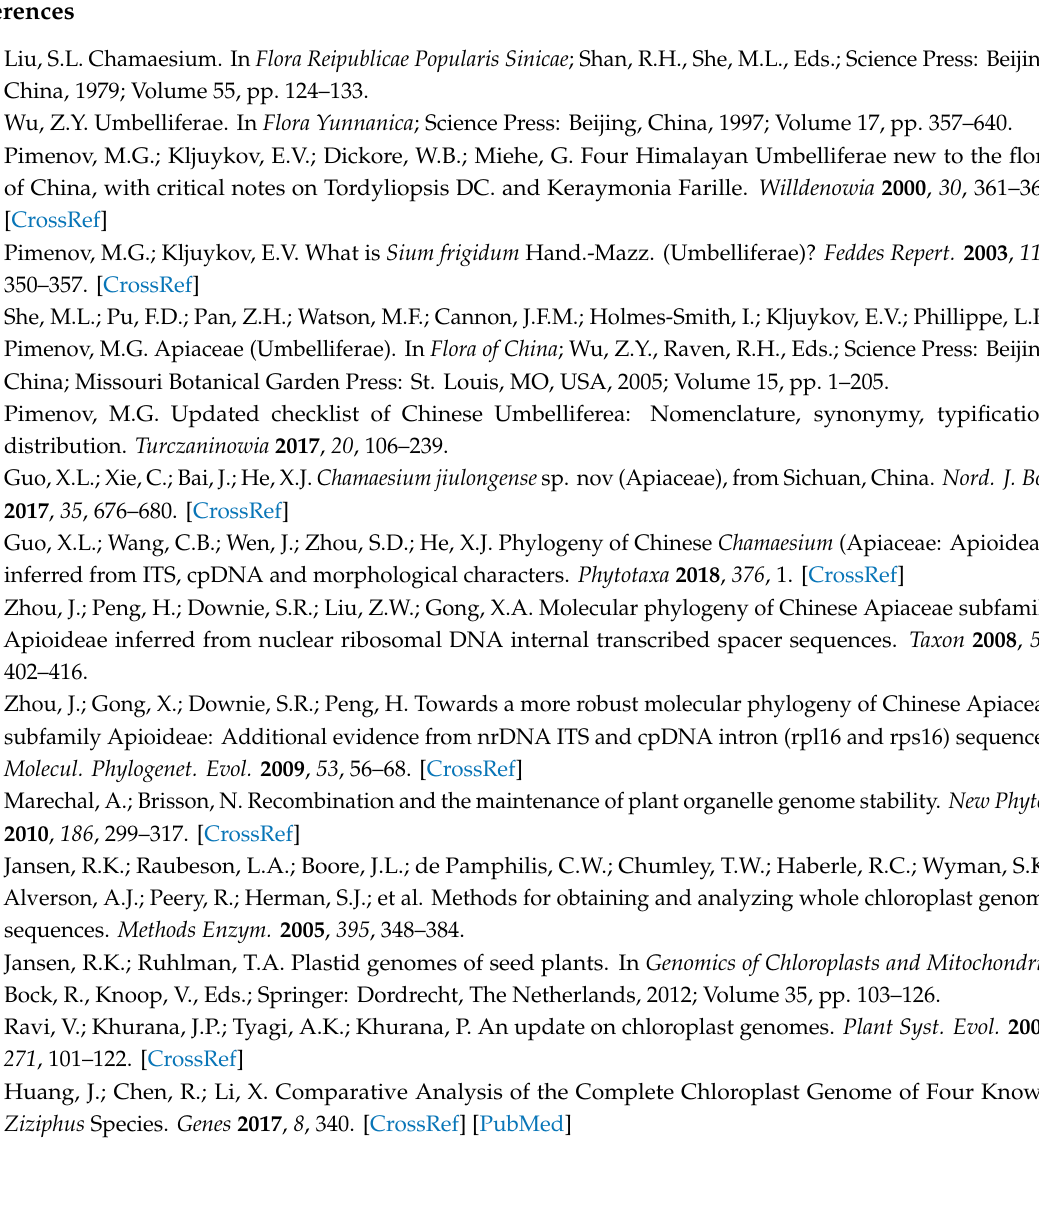
Table S1: Voucher details and GenBank accession numbers of taxa used in this study. Table S2: Summary of complete plastid genome features. Table S3: Statistics of simple sequence repeats in Chamaesium . Table S4: Statistics of codon usage bias in Chamaesium . Table S5: Comparative analysis of Ka / Ks value in Chamaesium . Author Contributions: Conceptualization, X.-L.G., H.-Y.Z., S.-D.Z. and X.-J.H.; Data curation, X.-L.G. and